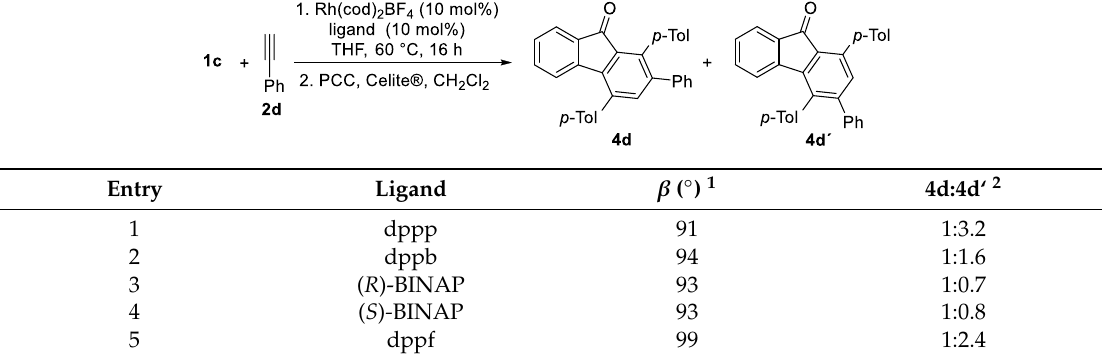
Table 2. Cyclotrimerization of 1c with 2d catalyzed by Wilkinson’s catalyst.